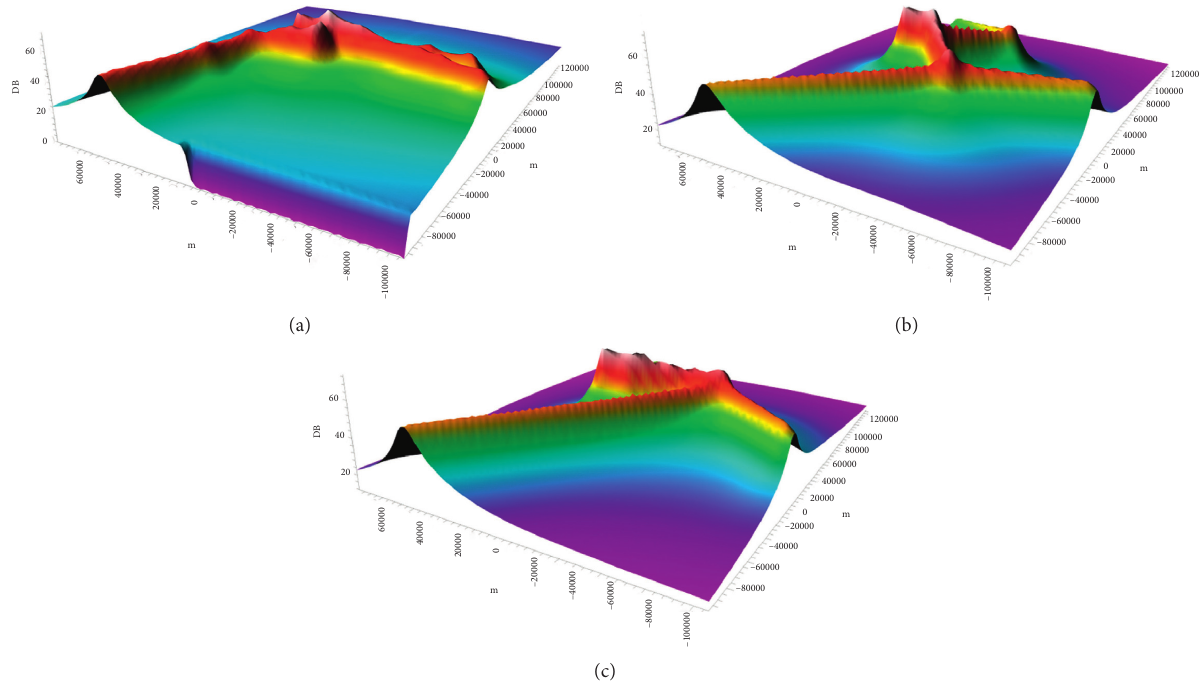
Figure 21: Noise surface diagram of the same arrival flow in three different flight procedures. (a) STAR. (b) Initial PM procedure. (c) Optimized PM